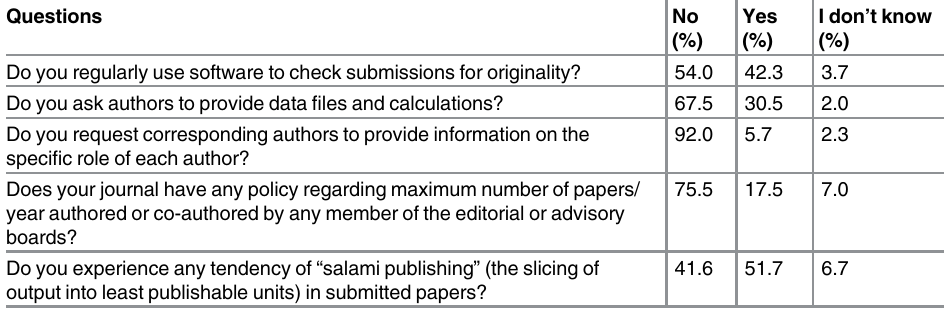
Table 6. Diffusion of practices related to misconduct management